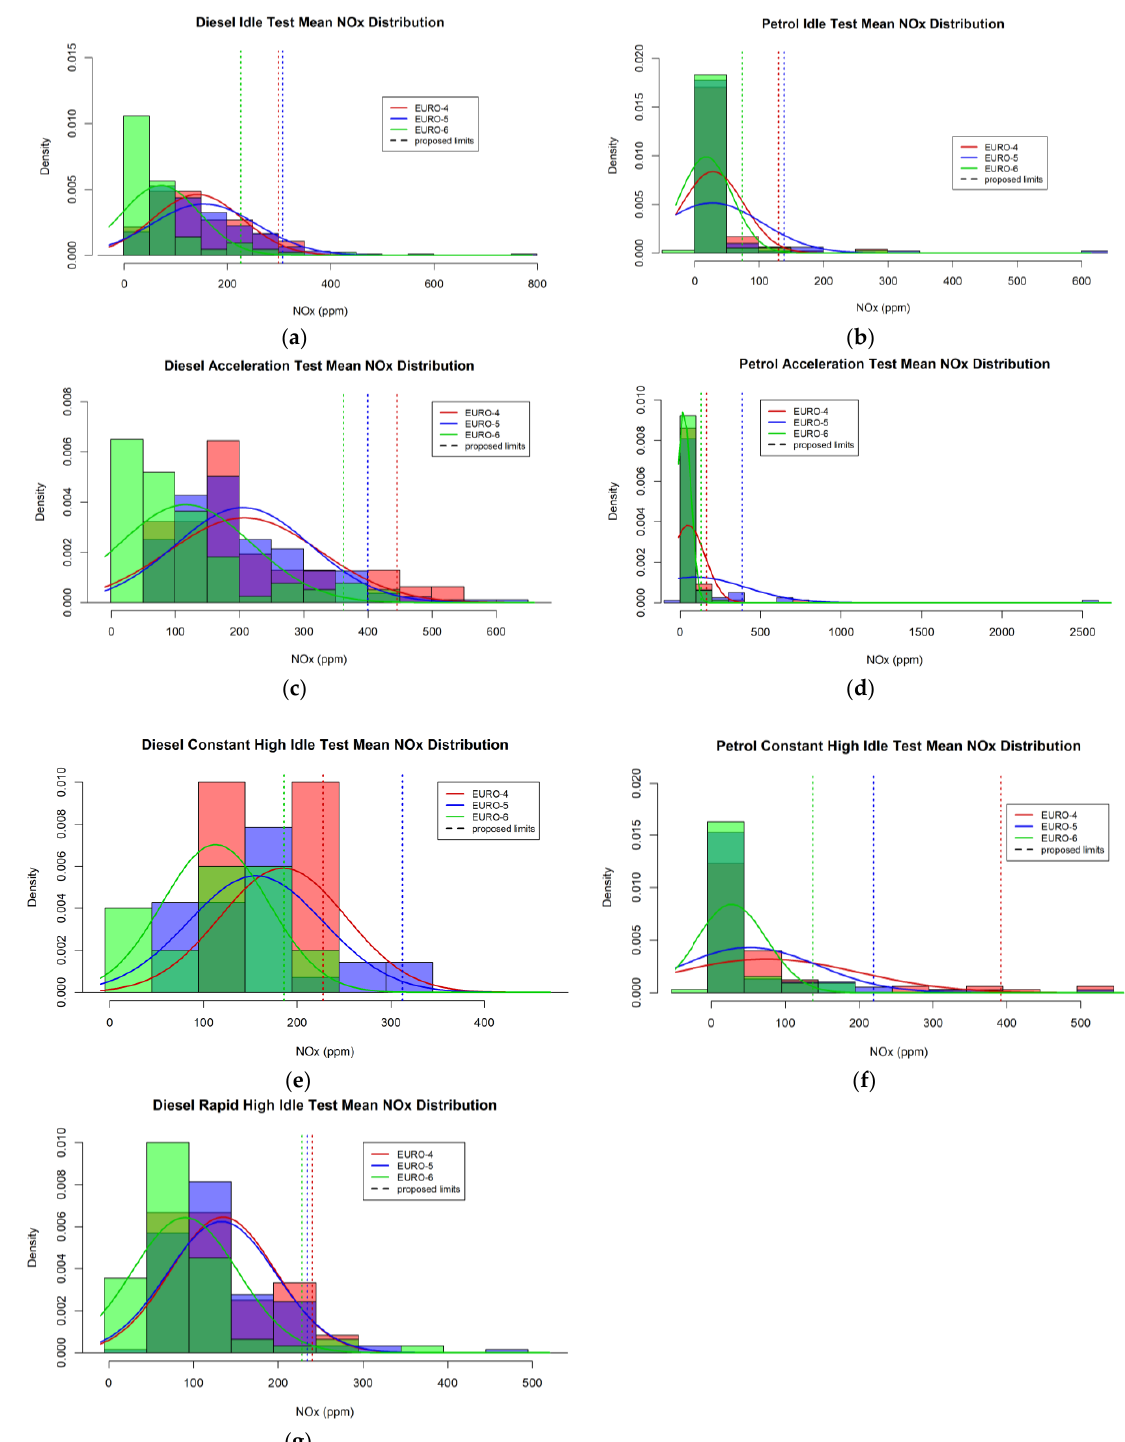
Figure 6. Diesel and petrol probability density distribution histograms for different test types, distributed into separate Euro standards (red bars – Euro 4, blue bars – Euro 5, green bars – Euro 6; colours are translucent to allow visualisation of all three Euro standards simultaneously), with 5% fail rate (i.e., 95th percentile) thresholds for each Euro standard marked by dashed lines: ( a ) diesel idle test; ( b ) petrol vehicle idle test; ( c ) diesel vehicle acceleration test; ( d ) petrol vehicle acceleration test; ( e ) diesel vehicle constant high idle test; ( f ) petrol vehicle constant high idle test; ( g ) diesel vehicle rapid high idle test.